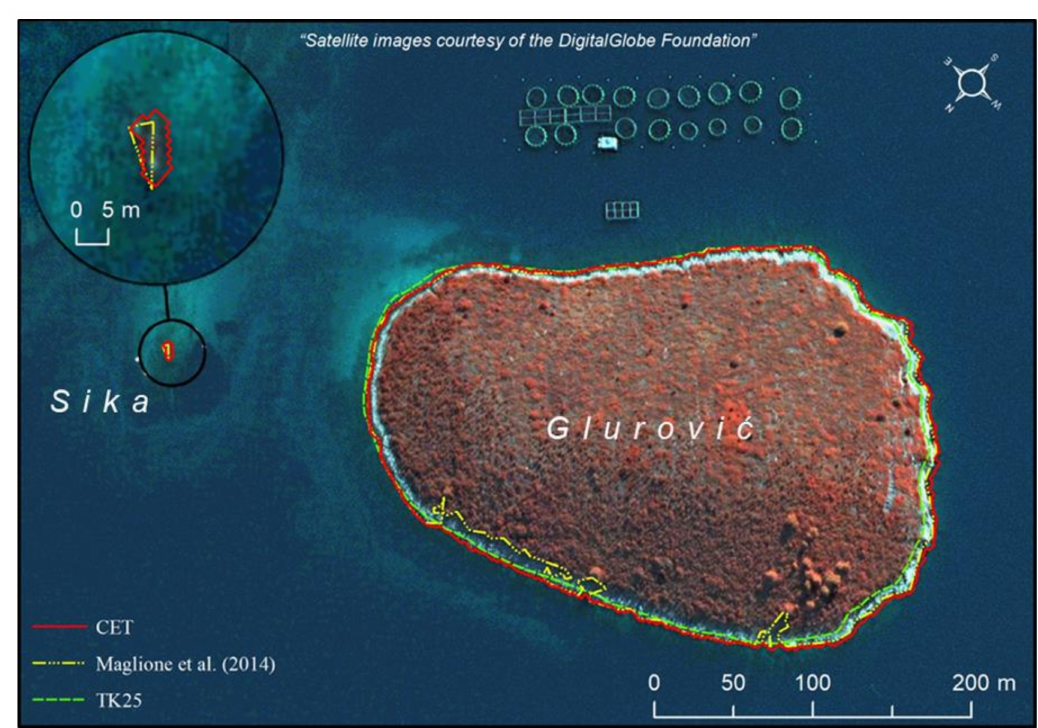
Figure 8. Visual comparison of coastline generalization